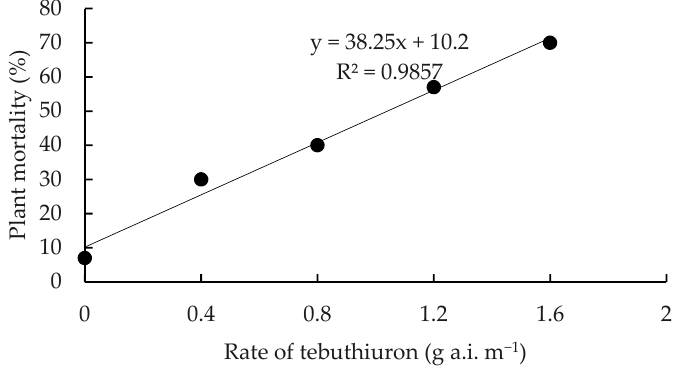
Figure 3. The relationship between application rate of tebuthiuron and mortality (%) of C. uruguayanus plants.